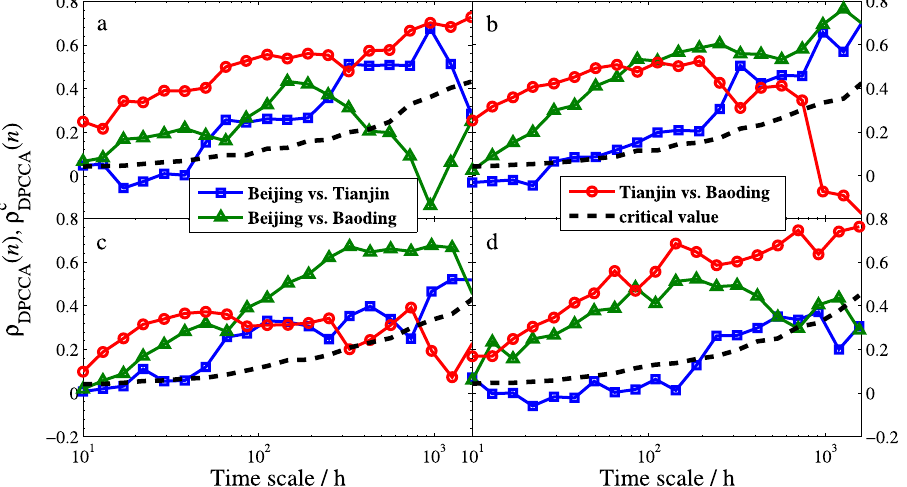
Figure 9. Statistical test of DPCCA coefficients among the three cities. ( a – d ) Are for winter, spring, summer, and fall, respectively. The dashed line represents the critical value of ρ DPCCA which is obtained from 10000 times Monte-Carlo simulations with 99% confidence level. Below this line suggests no cross-correlated